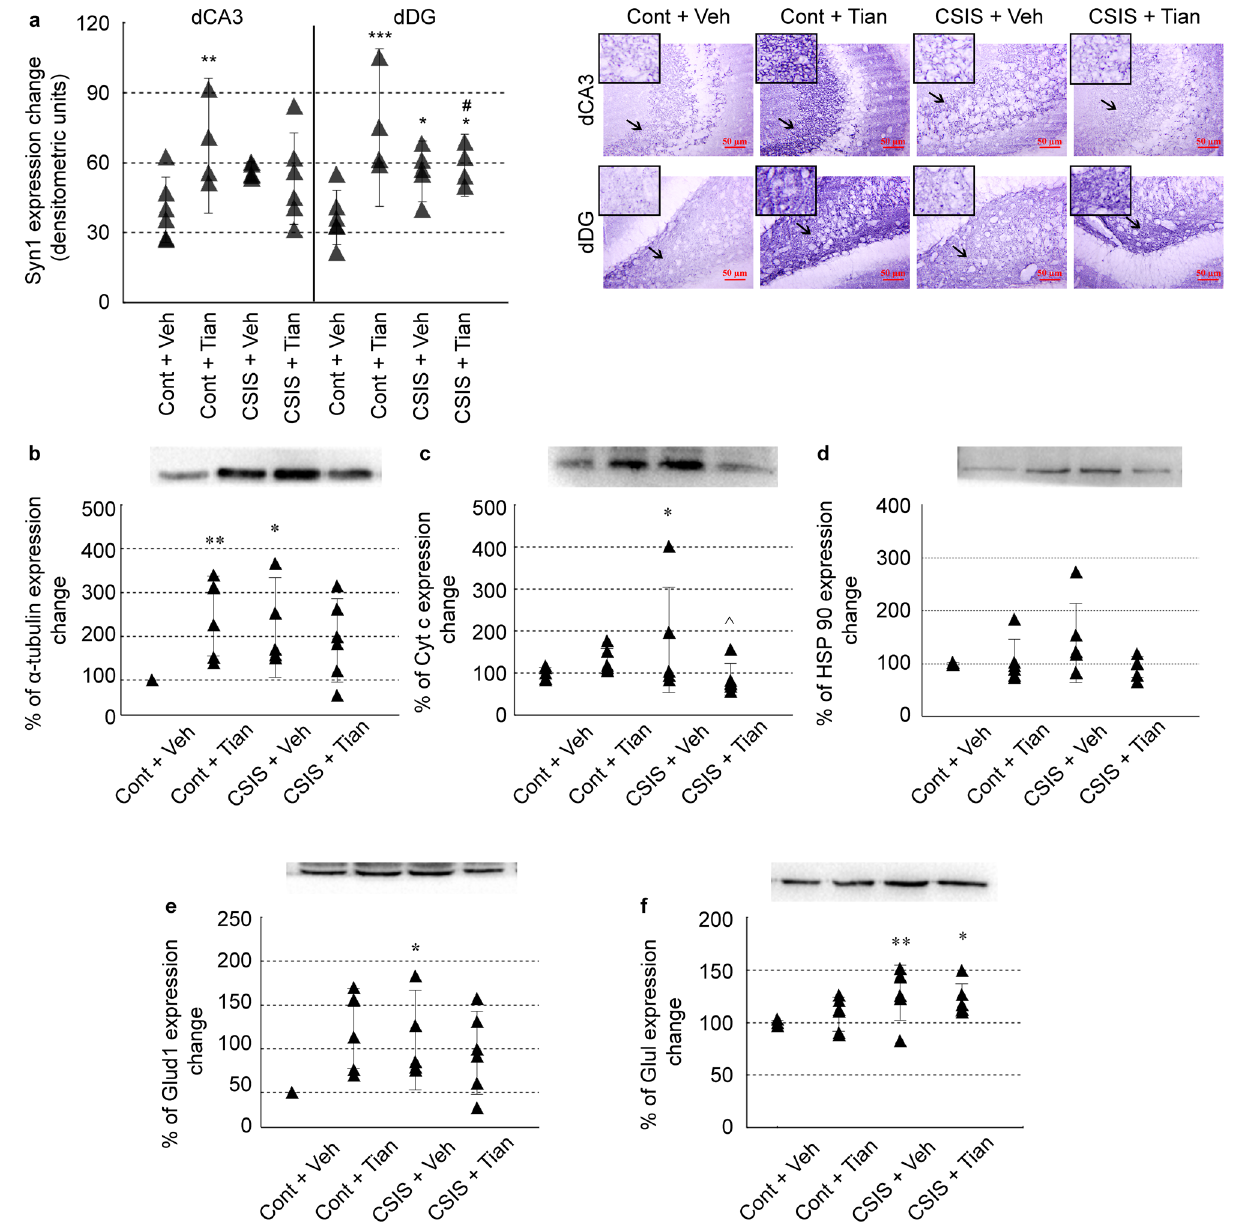
Figure 5. Validation of synapsin-1 (Syn1), α-tubulin, cytochrome c (Cyt c), HSP90, glutamate dehydrogenase 1 (Glud1) and glutamine synthetase (Glul) in synaptosomal fractions of rat hippocampus from Controls, Control + Tian, CSIS and CSIS + Tian groups by Immunohistochemical ( a ) and Western blot analysis ( b – f ). Data were expressed as mean ± SEM, n = 4–6 independent measurements in each group. Significant differences between groups obtained from two-way ANOVA analyses followed by Duncan’s post-hoc test are indicated as follows: *p < 0.05, **p < 0.01, comparisons always against Controls; ^p < 0.05, CSIS + Tian vs. CSIS. Displayed blots are cropped images of representative examples of several Western blots performed. Full-length blots are presented in Supplementary Figure S1. The missing parts of the membranes are due to unsatisfactory antibody hybridization, and thus were not represented or used in the final